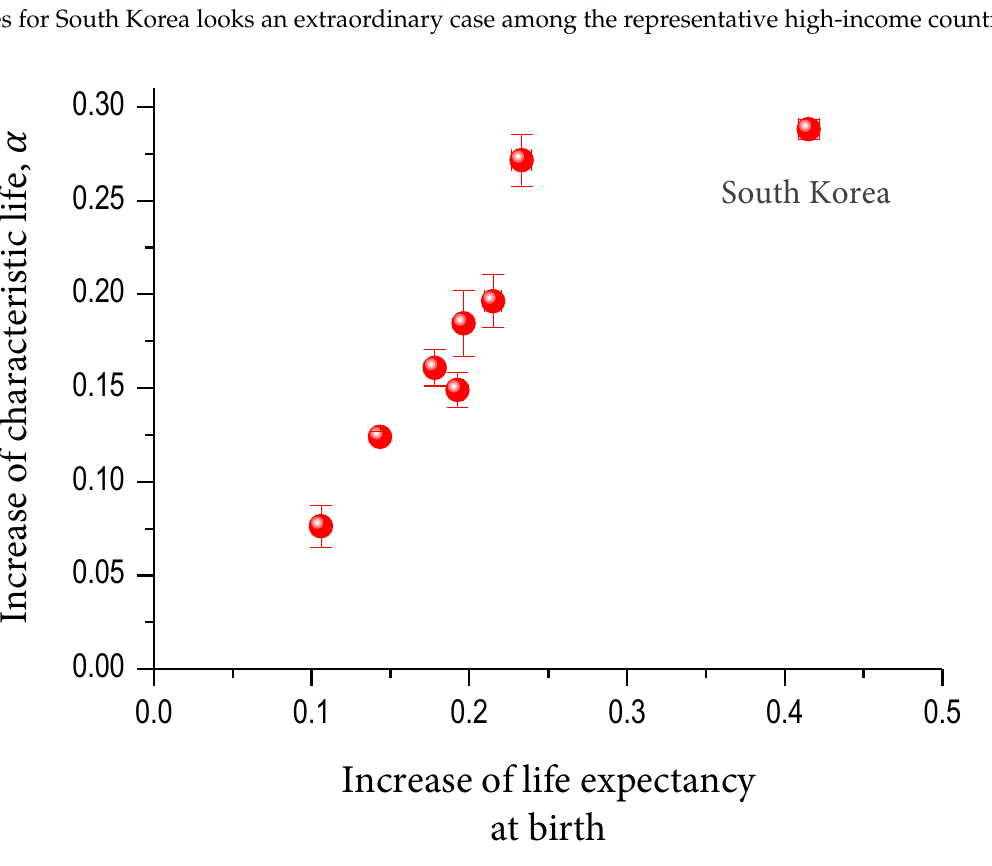
Figure 3. Association of the characteristic life, taken from Figure 2, with the life expectancy at birth per decade in representative industrialized countries, taken from the Organization for Economic Cooperation and Development